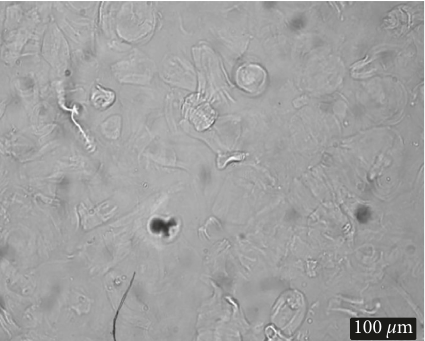
Figure 3: Optical micrographs of a hydrogel sample made by ionotropic gelation from CMC 1.6% and CaCl 2 4.9% w/v. Scale